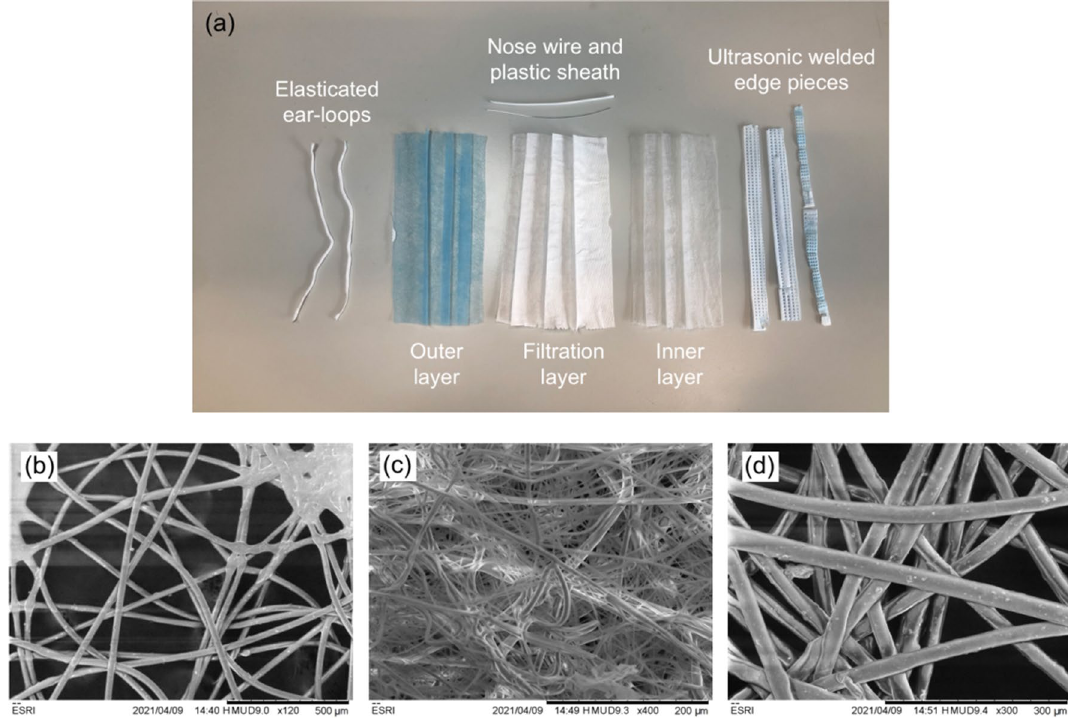
Figure 1. Components of the disposable mask. ( a ) A photograph of a fully disassembled mask with the component pieces labelled. ( b ) SEM image of the untreated mask outer layer. ( c ) SEM image of the untreated mask filtration layer. ( d ) SEM image of the untreated mask inner layer.